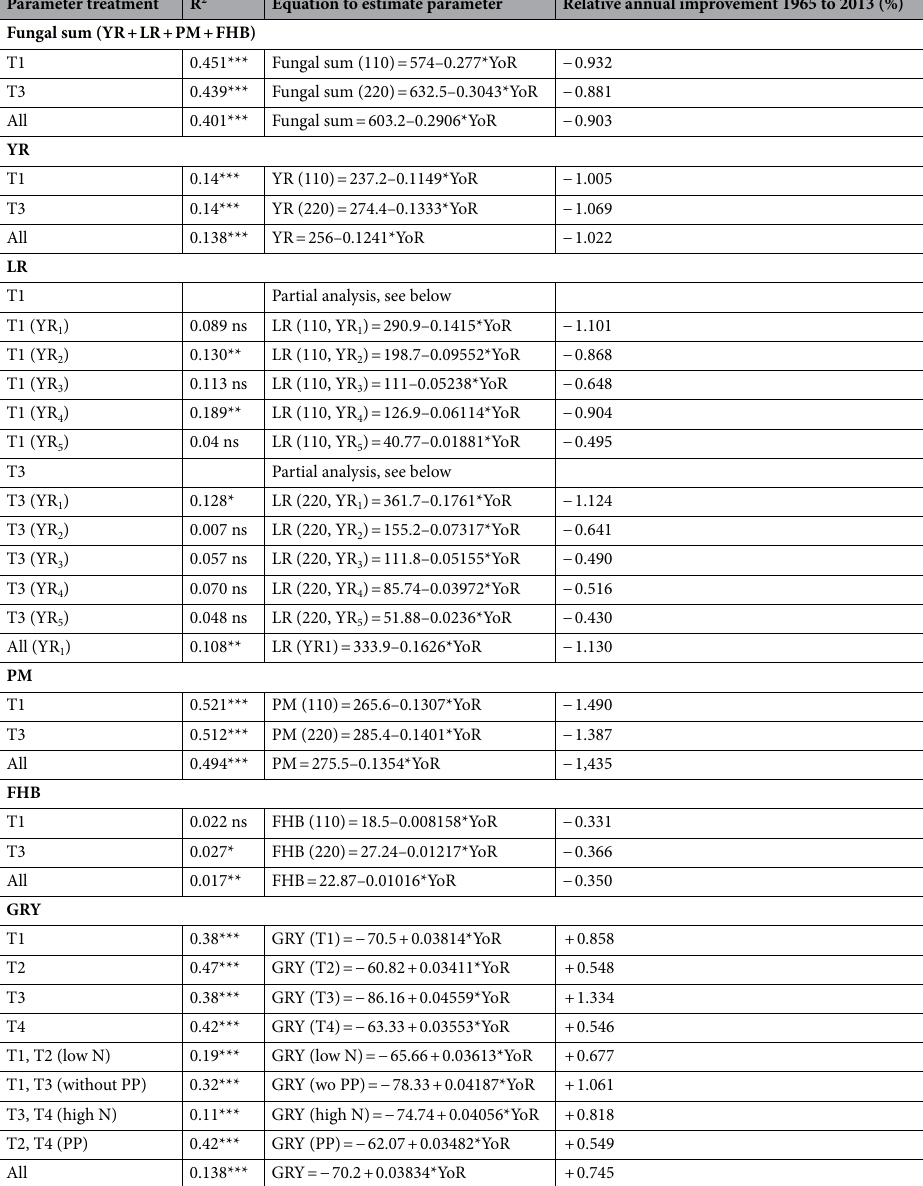
Table 5. Bivariate analysis between diseases (YR, LR including LR by YR classes, PM, FHB), and yield (GRY) with years of cultivars release based on LSmeans (observations treatment-specific, over years and repeats) assuming a linear model. Results contain phenotypic variance explained (R 2 ), significance levels of p values of each model tested, equations of linear fit to estimate breeding progress from year of release (YoR), and relative annual improvement of each parameter between 1965 and 2013 (estimated value of 1965 set to 100%). T1—T4, treatment 1 to 4; YR, stripe rust; LR, leaf rust; YR 1 -YR 5 , quantile classes of YR infestation (YR 1 < 4.0455%, YR 2 4.0455 to 6.1509%, YR 3 6.1509 to 9.1852%, YR 4 9.1852 to 13.242%, YR 5 13.242 to 31%); PM, powdery mildew; FHB, Fusarium head blight; GRY, grain yield; Signif. p, significance level of p value: *** < 0.001, ** <